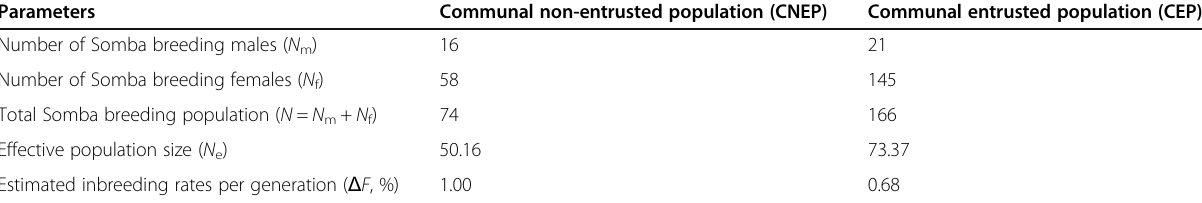
Table 6 Effective population sizes and inbreeding rates of the Somba cattle populations in Korontiere